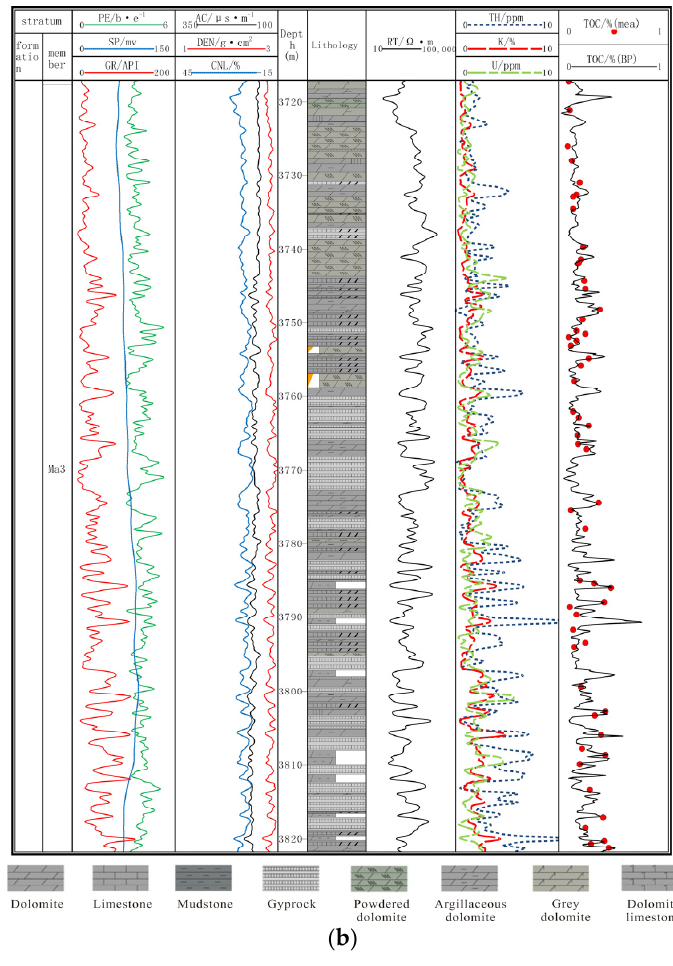
Figure 10. TOC prediction of LT1 well based on the neural network method: ( a ) Ma 5 6–10 and ( b ) Ma 3.